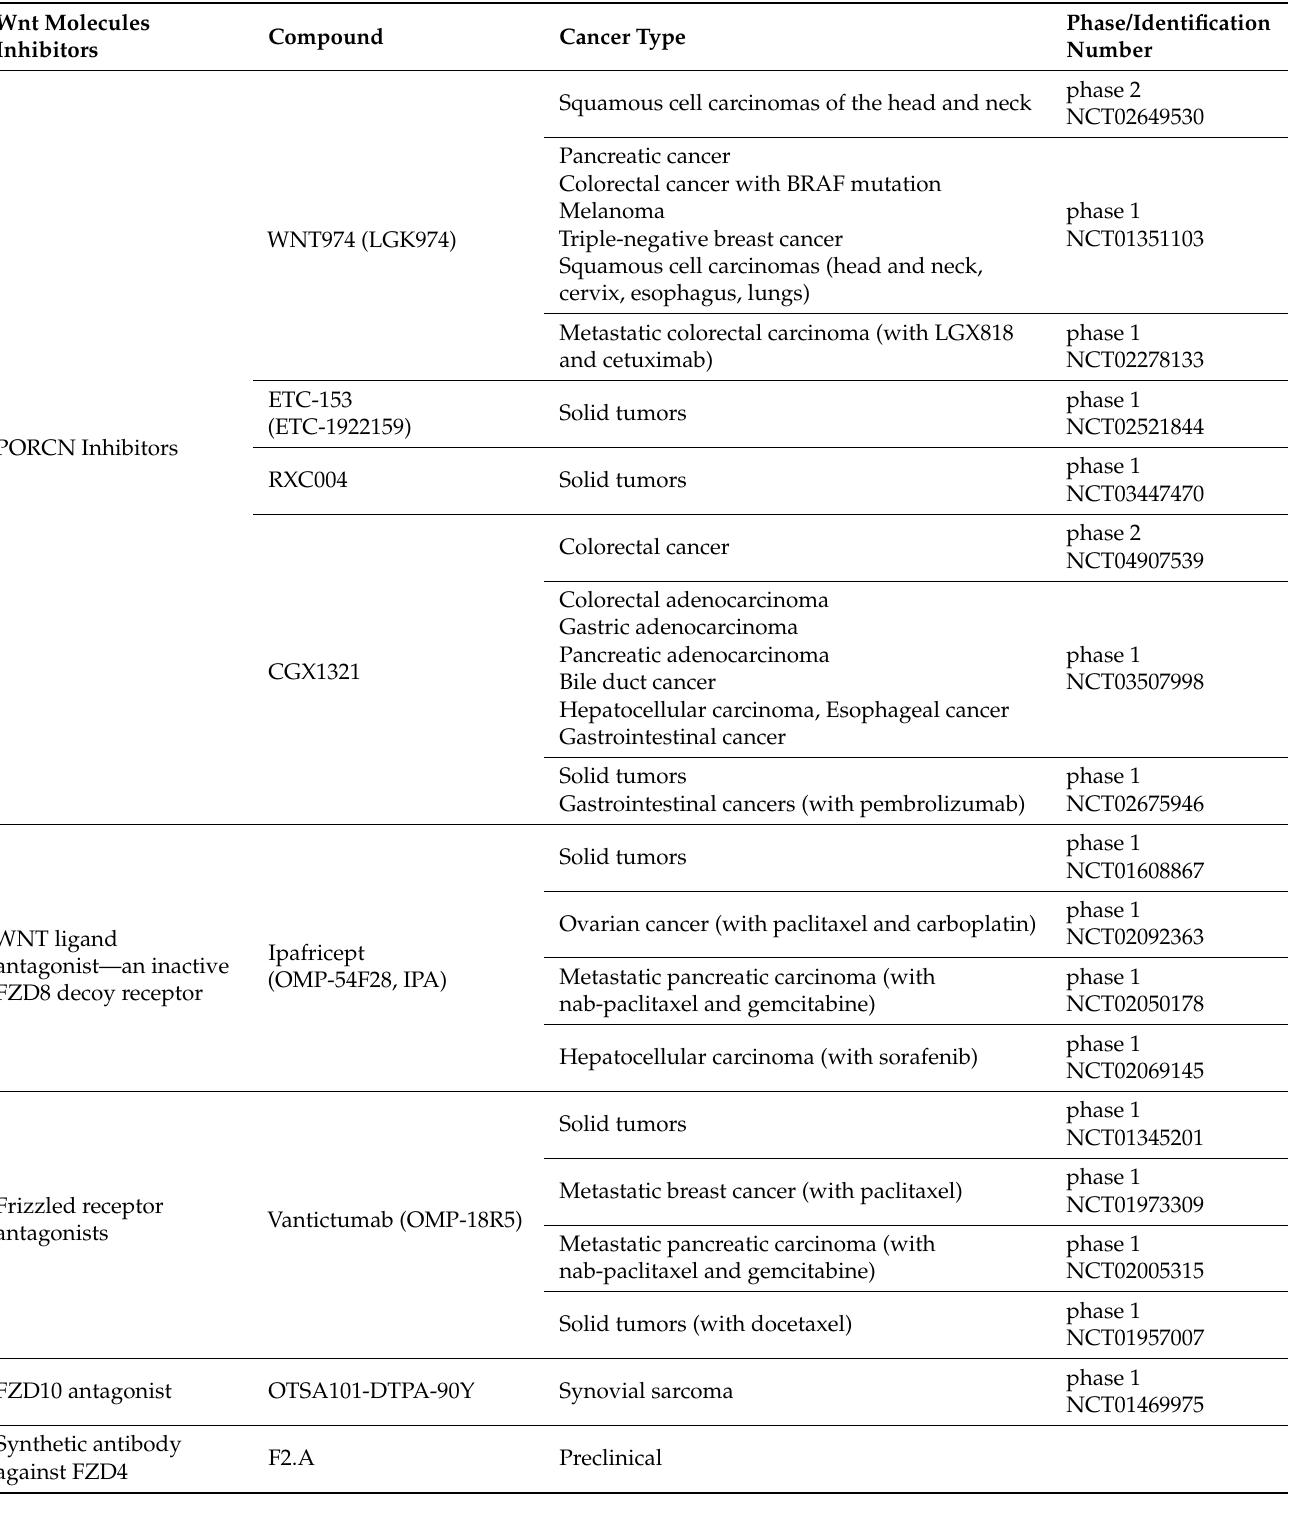
Table 1. Inhibitors of the canonical Wnt pathway. Adapted with permission from Ref. [5]. Courtesy of Professor